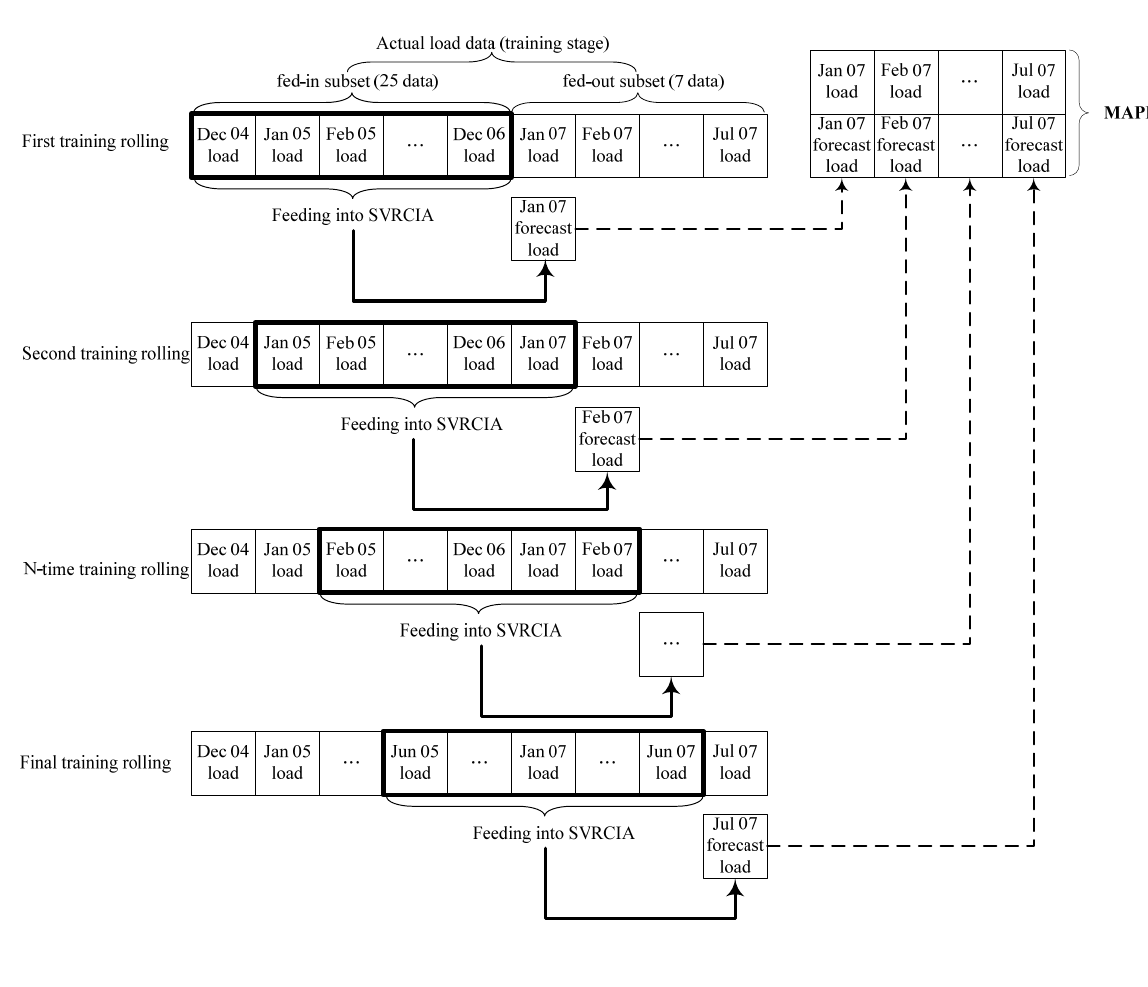
Figure 2. The rolling-base forecasting procedure (training